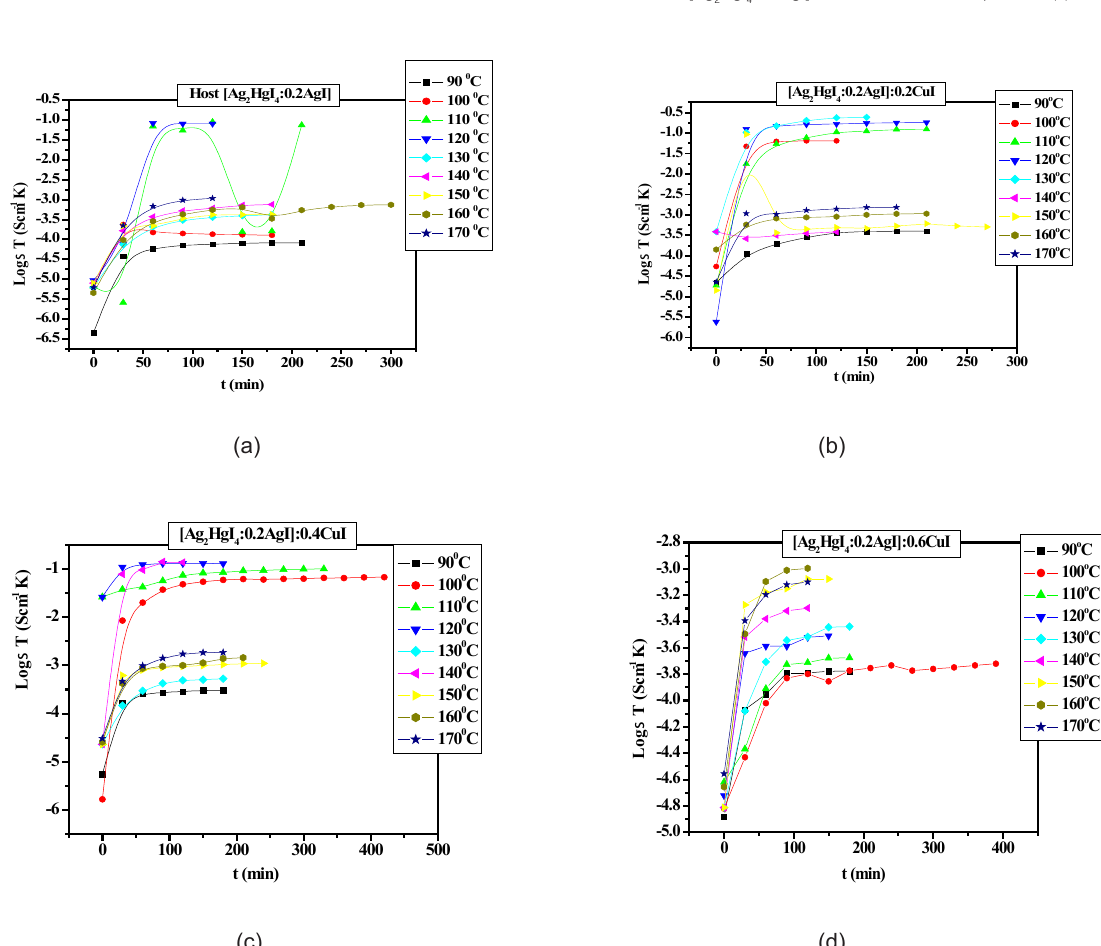
Figure 4. Log k (rate constant) vs. 1/T (K -1 ) plots for mixed composite systems, [Ag